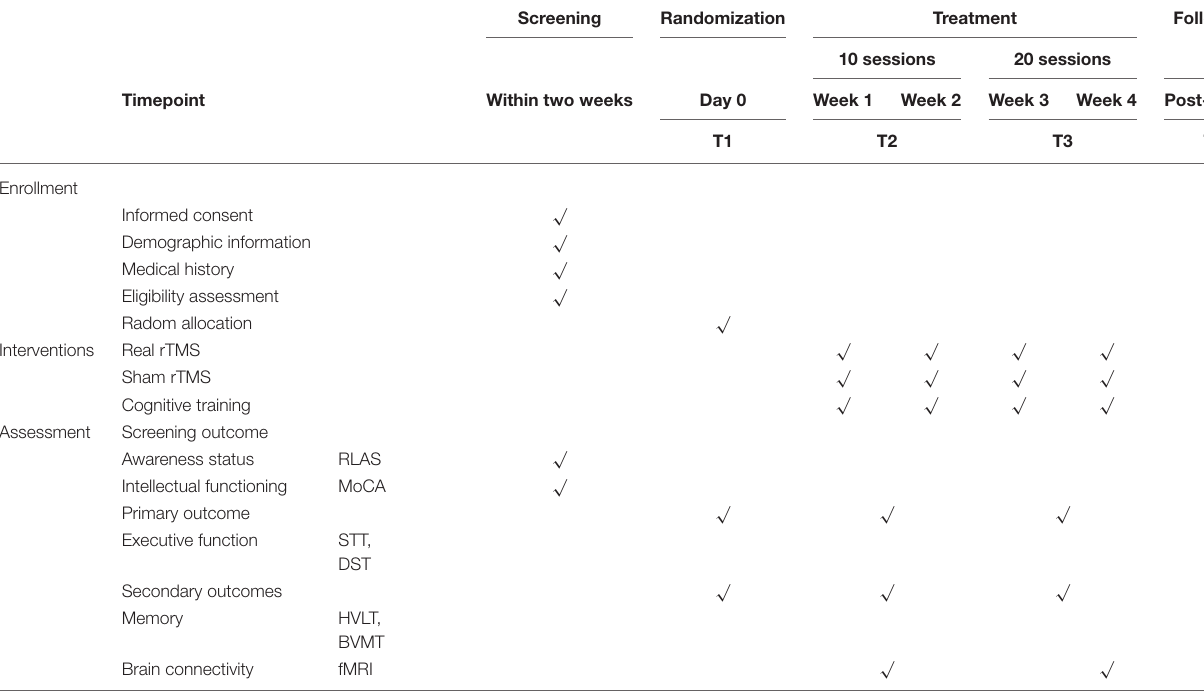
TABLE 1 | Schedule of enrollment, assessment, and